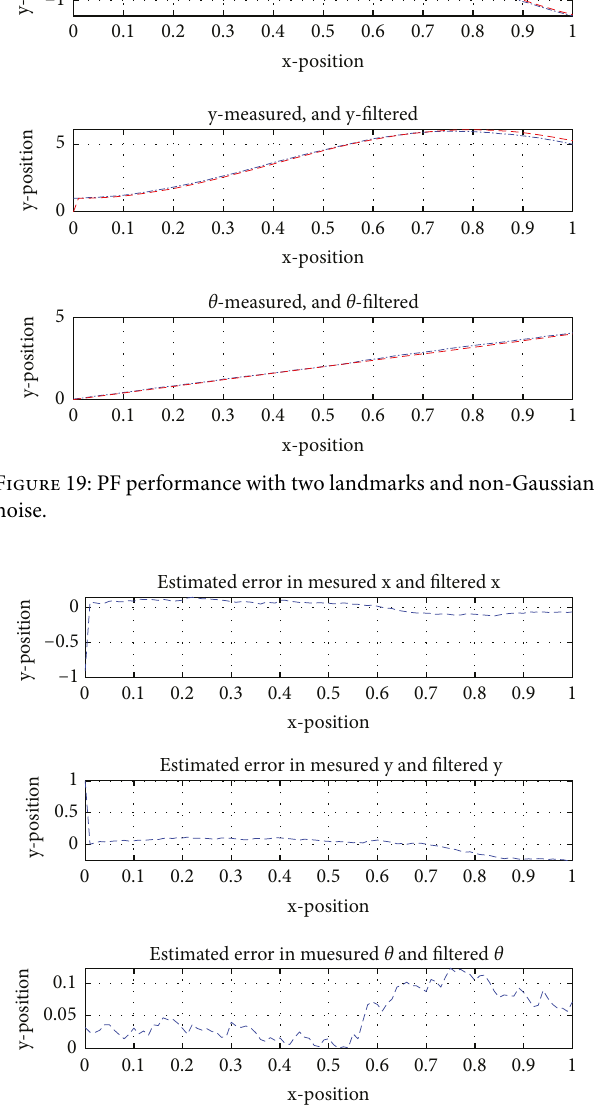
Figure 20: The induced estimation error from the PF (two landmarks and non-Gaussian noise).